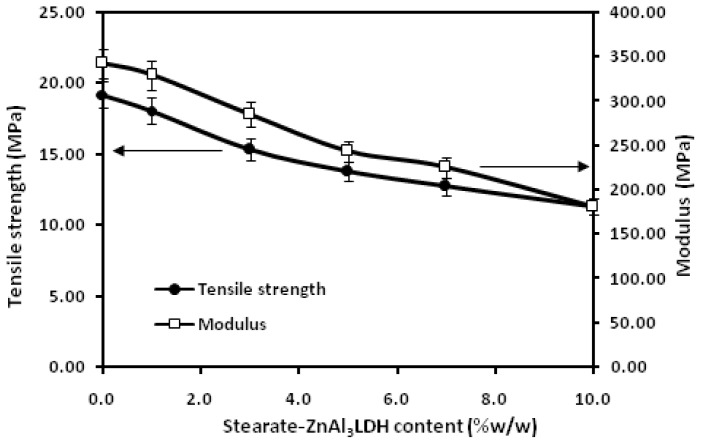
Tensile strength and elastic modulus of PLA with different stearate-Zn3Al LDH content.